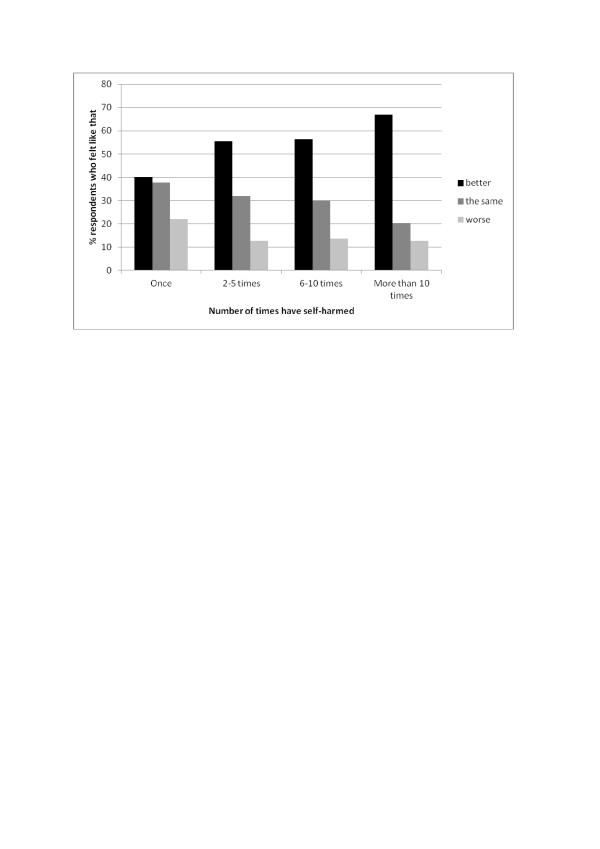
Association between frequency of self-harm and how respondent felt subsequently.